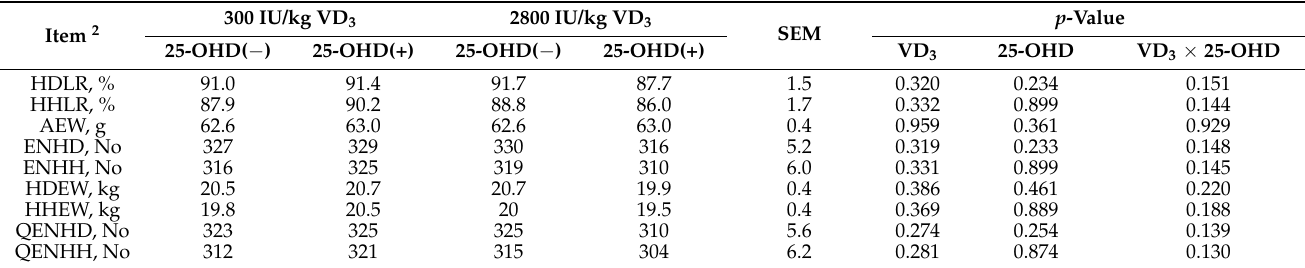
Table 3. Effects of VD 3 level and 25-OHD in the diet of 1–20-week-old laying hens on laying performance (21–72 weeks) 1